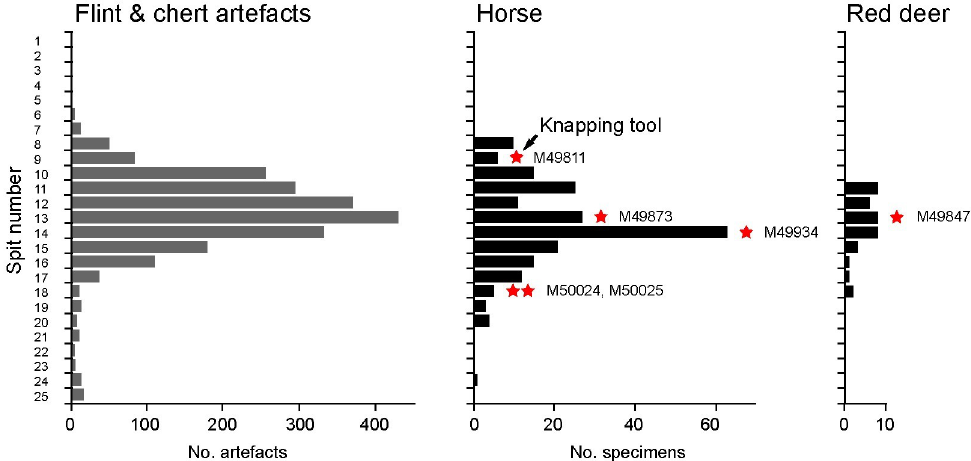
Fig 13. Gough’s Cave: Vertical distribution of flint and chert artefacts (based on [13]), Pleistocene horse and red deer bones [41, Table 1] and knapping tools recovered during excavations supervised by Parry in 1927–1931 (Fig 1). The deposits were excavated in six-inch (~15 cm) layers (or spits). Note that pottery and Holocene bones are confined to spits 1–9 and the horizontal spits cutting through the natural slope of the deposits gives the illusion of stratified sequence [13,